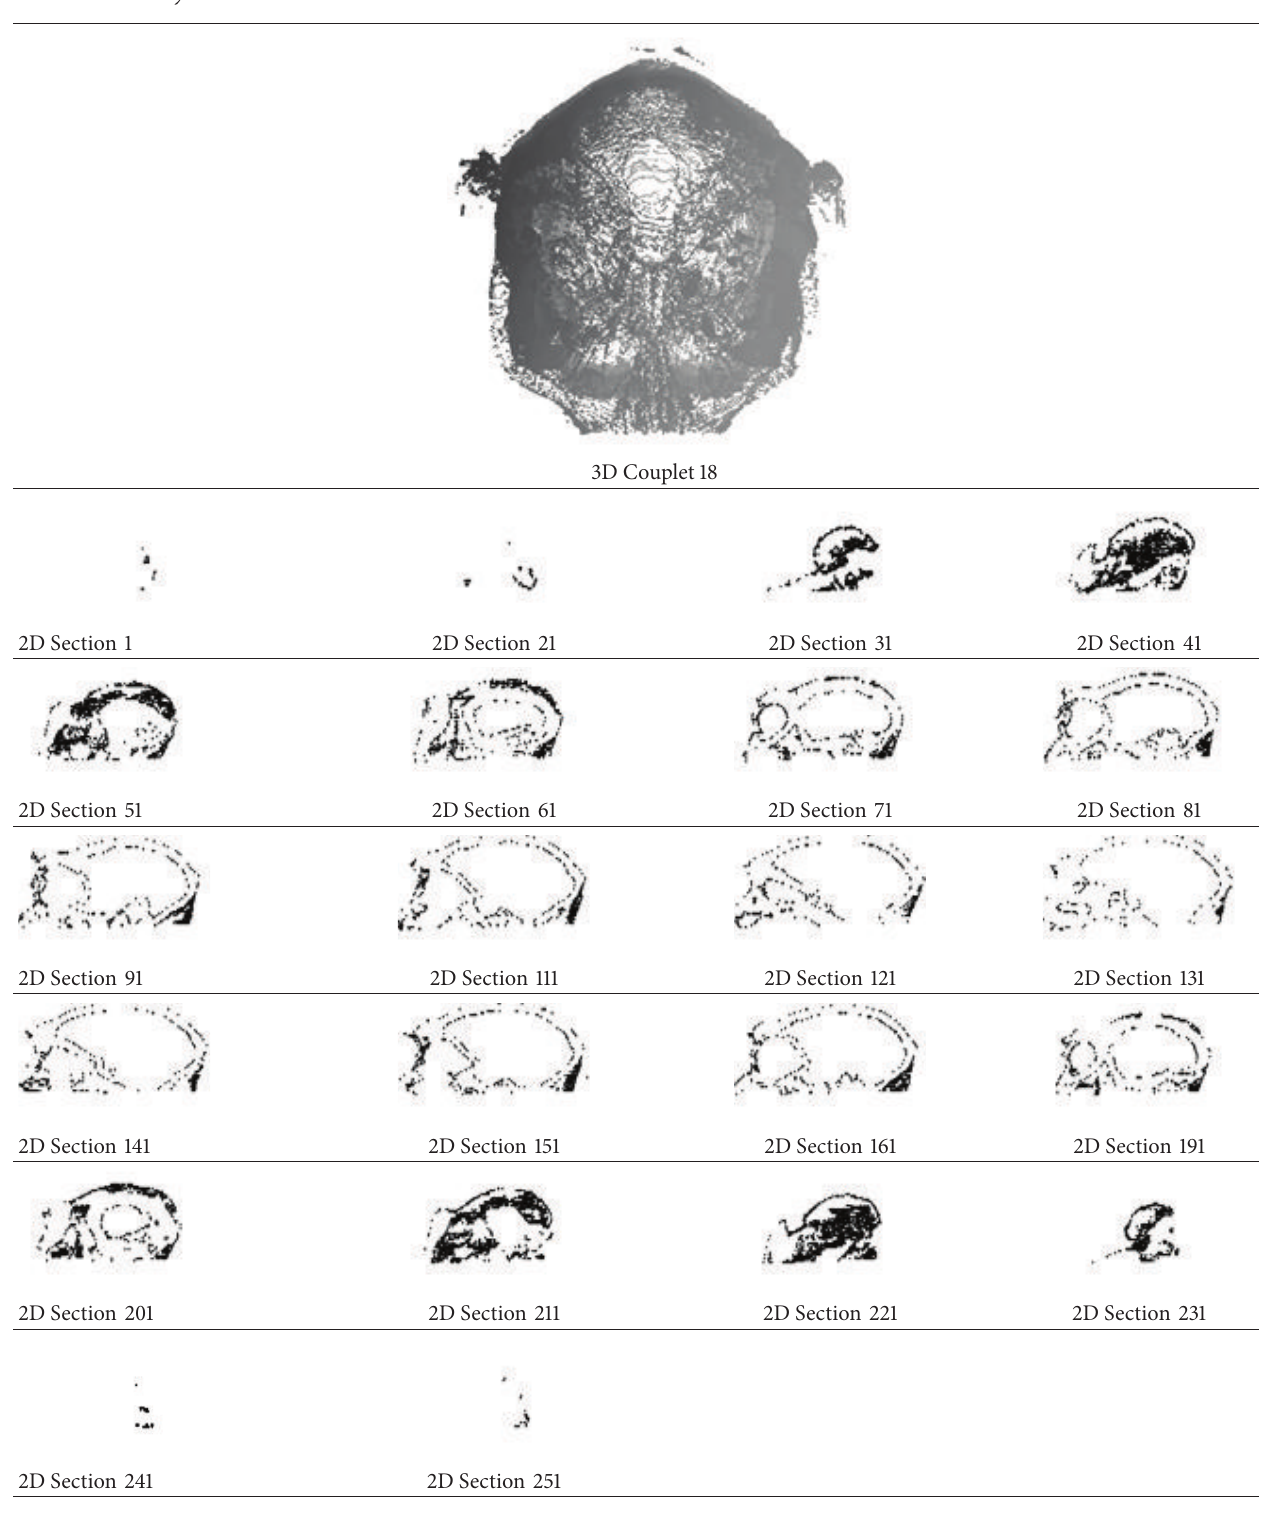
Table 6: Visualizing some 2D Sections perpendicular to 𝑋 1 -axis which were processed from a 3D Couplet of the 4D-OPP associated to dataset CT-Monkey